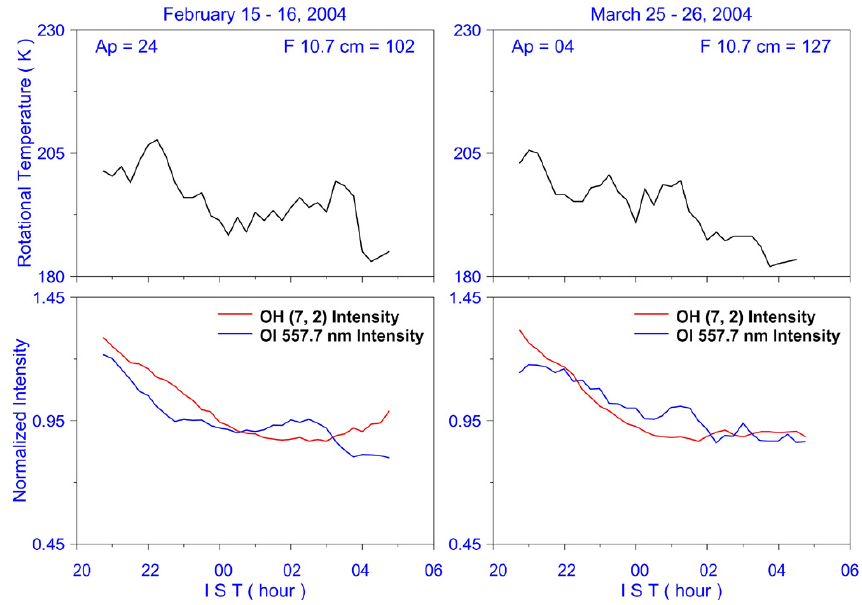
Fig. 3. Simultaneous observations nocturnal variations of OI 557.7nm emission, OH Meinel band and the derived OH temperatures (the variation of OH temperature on the night of 15–16 February 2004 has already been reported by Parihar and Mukherjee,